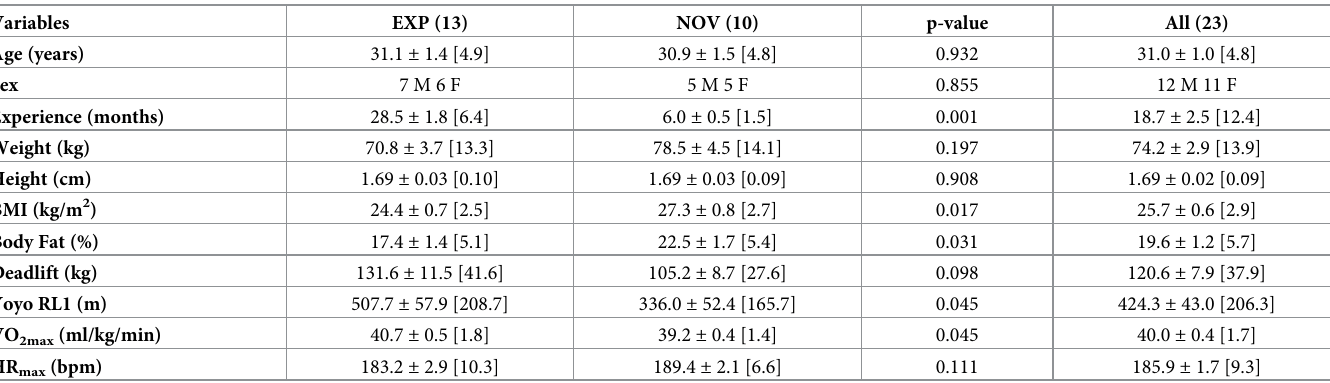
Table 1. Characteristics of the participants (M ± SEM